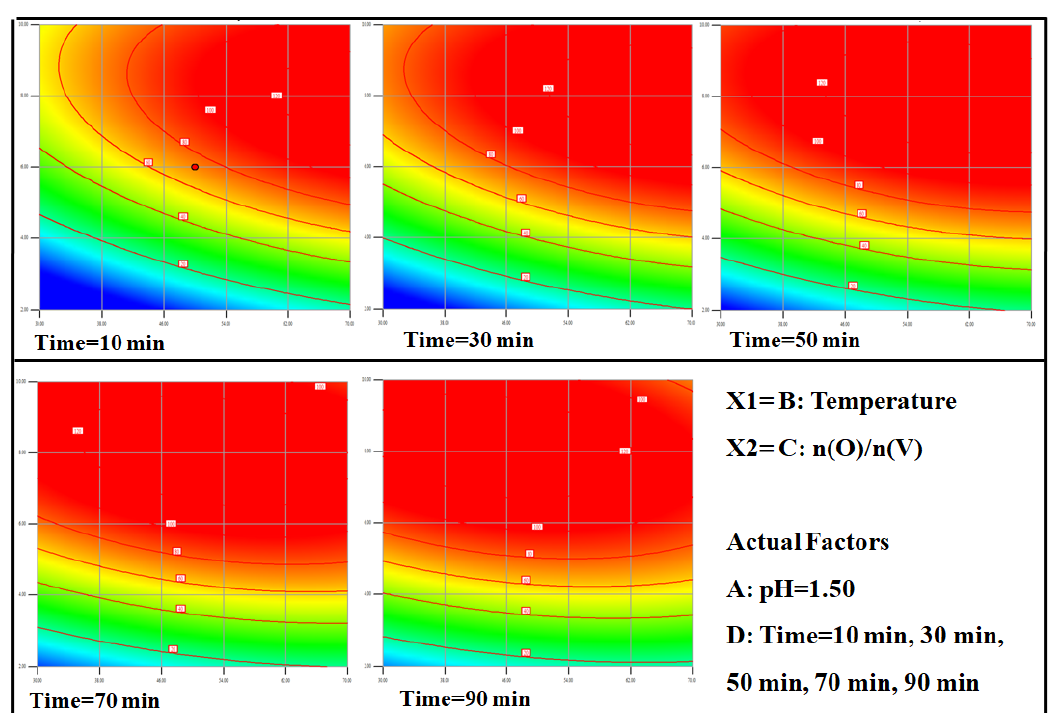
Figure 9. Response surface plots for factors (B to C).